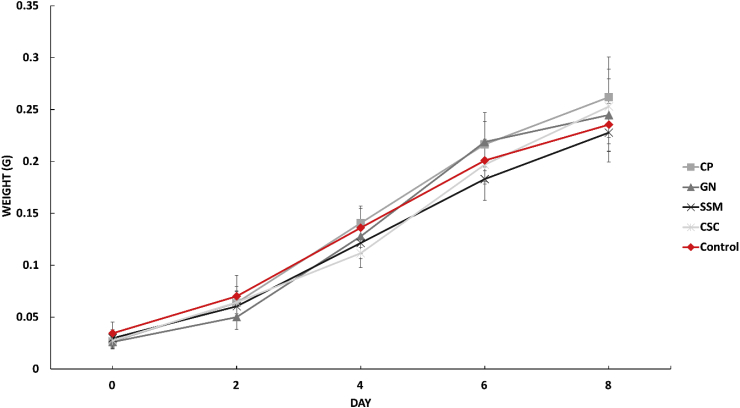
Average individual larval growth over time with SD.